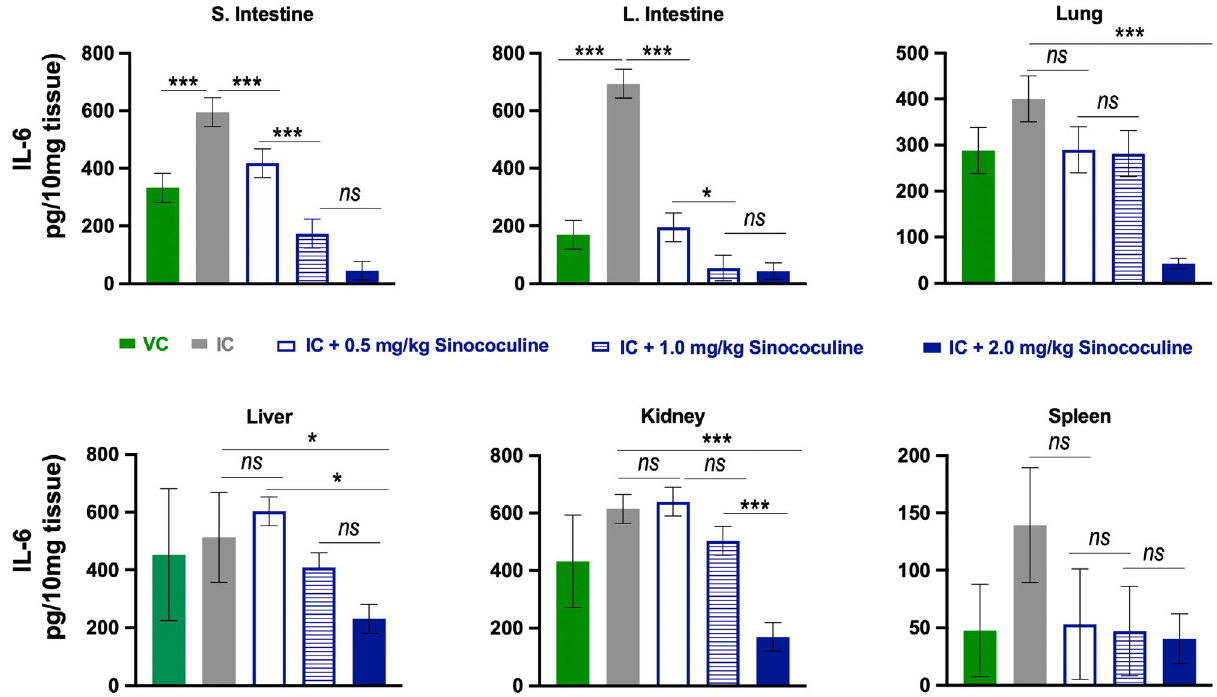
Figure 6. Sinococuline reduces IL-6, a proinflammatory cytokine, in different organs of severely DENV- infected AG129 mice. The 100 µl of tissue homogenate supernatants from the corresponding experimental groups described in Fig. 5, were utilized for the evaluation of IL-6 by using mouse IL-6 ELISA kit. The assay was performed as per manufacturer’s instructions, levels of IL-6 were calculated and graphs were plotted through GraphPad prism. The statistical levels of difference of IL-6 between the groups were analyzed by Two-way ANOVA with Bonferroni’s multiple comparison test, where ns : not significant ( p > 0.05), ***very significant ( p < 0.001), *significant ( p ≤